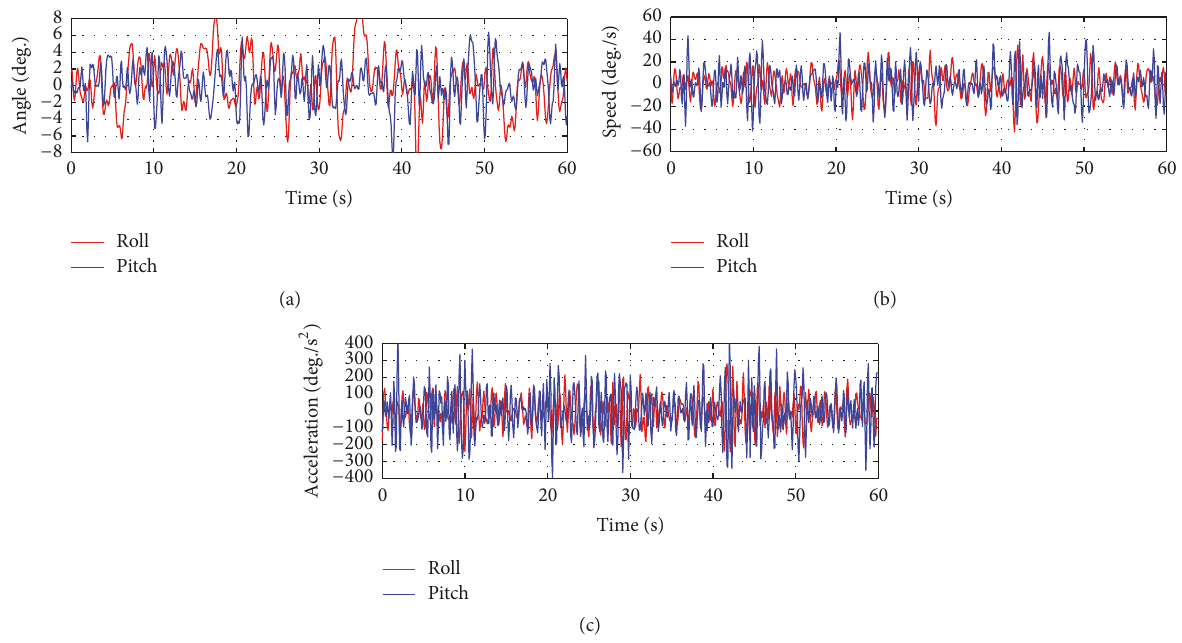
Figure 9: Estimation results of position, speed, and acceleration for roll and pitch motions. (a) Position; (b) speed; (c) acceleration.